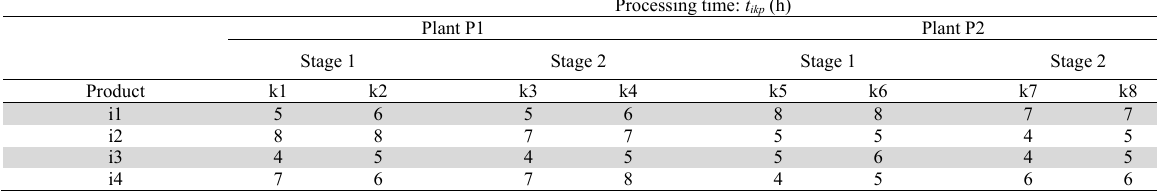
Processing times of orders for Example 1